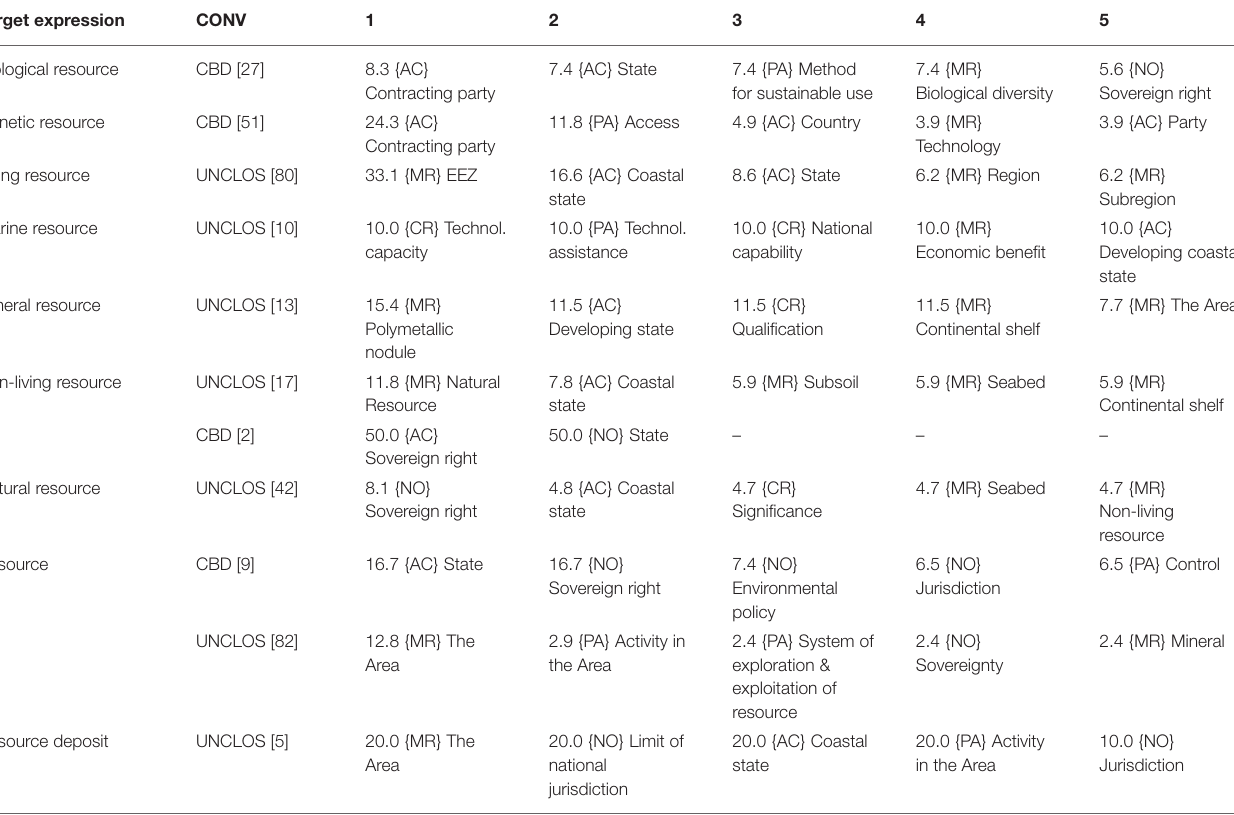
TABLE 1 | Target expressions (1st column), convention (2d column), and neighbour expressions ranked (1 to 5) by decreasing rank/occurrence index (given above each expression). In bracket after the convention acronym, the number of neighbour expressions from which the nearest expressions are found. Target